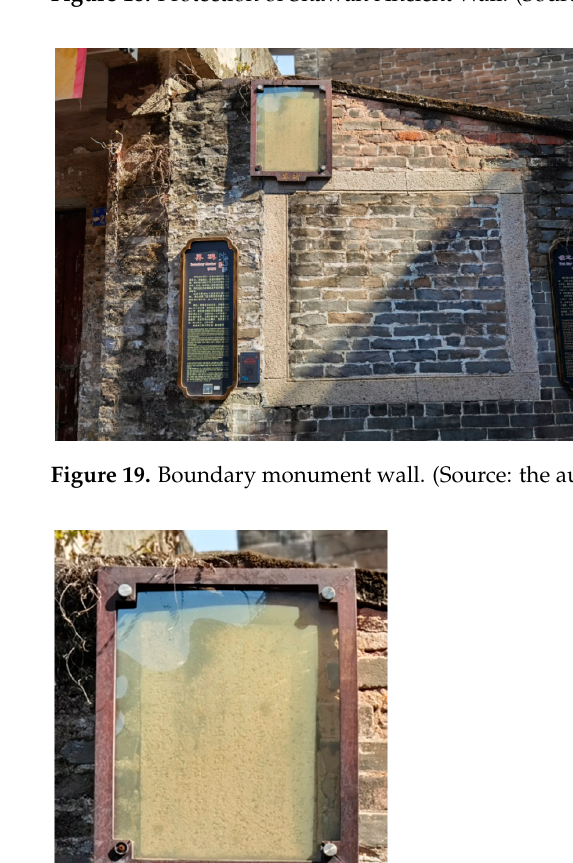
Figure 18. Protection of Shawan Ancient Wall. (Source: the authors).